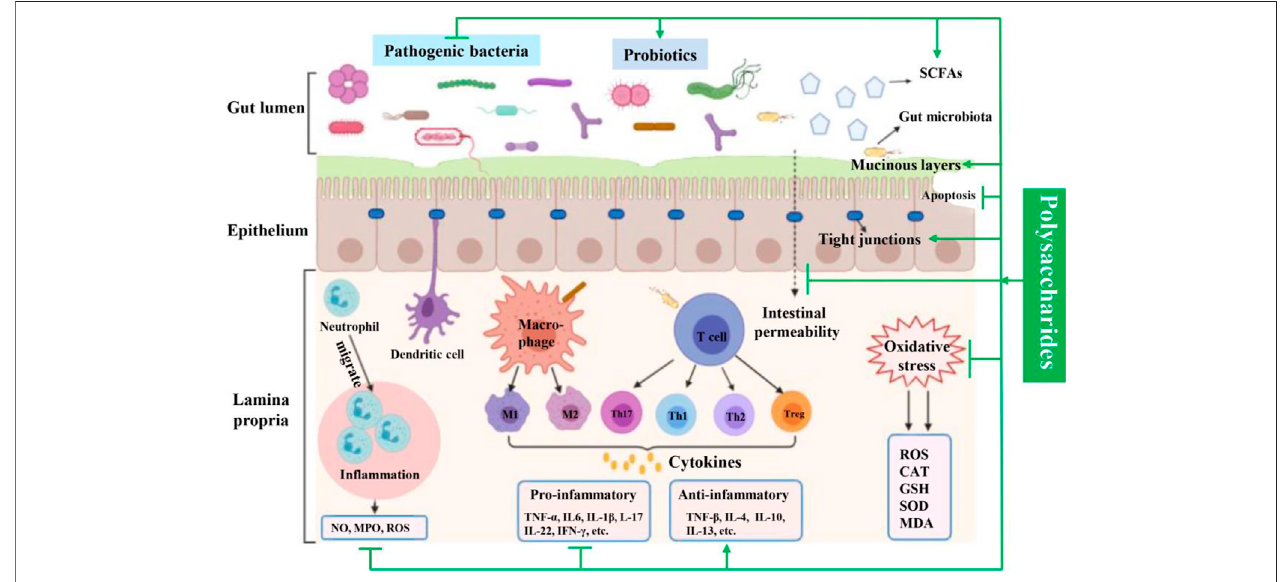
FIGURE 4 | Involved mechanisms of natural-derived polysaccharides in the treatment of IBD (promotion and inhibition).